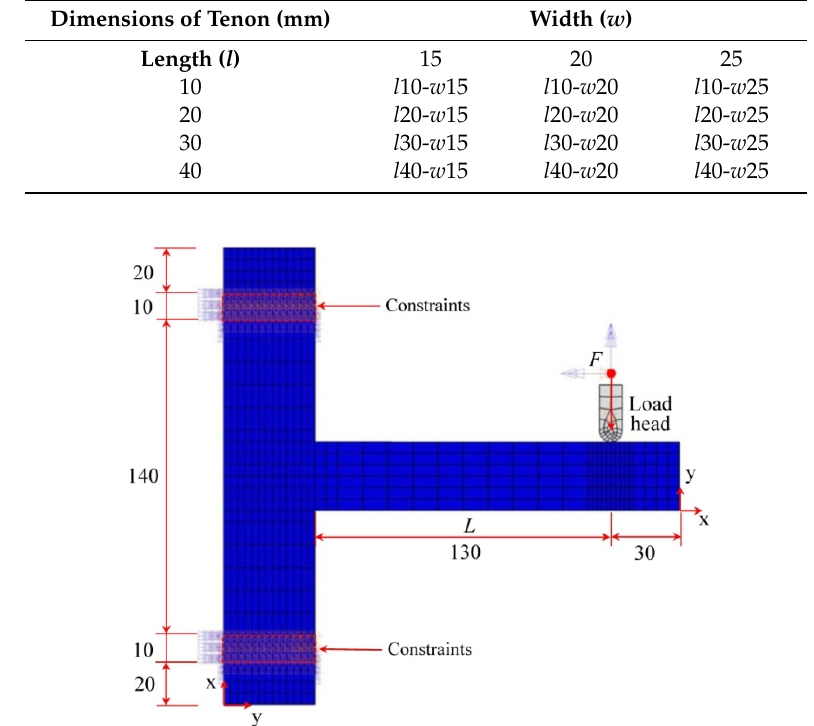
Table 2. Combinations of tenon width and tenon length evaluated in this study.